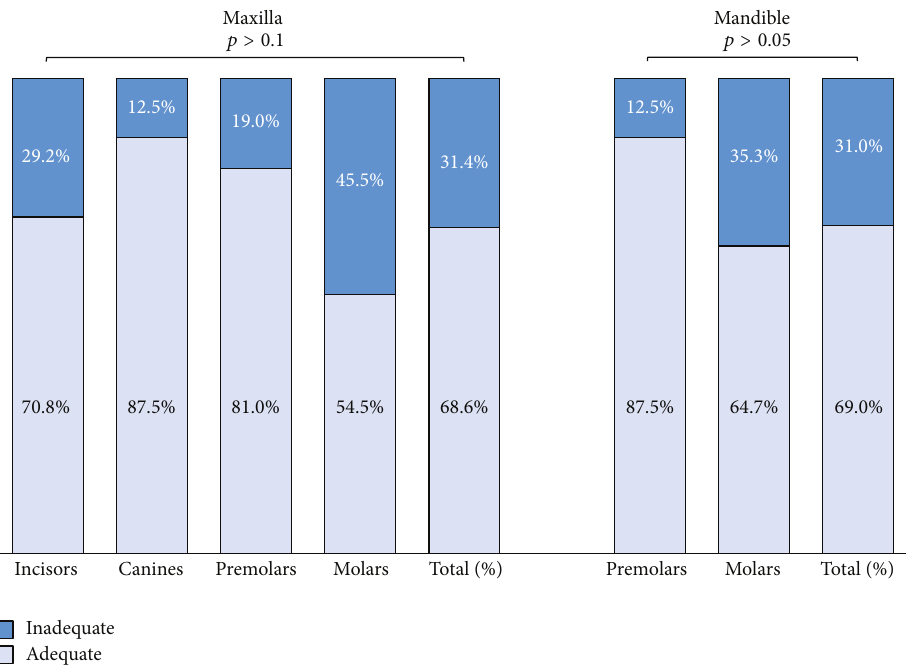
Figure 4: Taper quality (%) in maxillary and mandibular root canal-filled teeth.